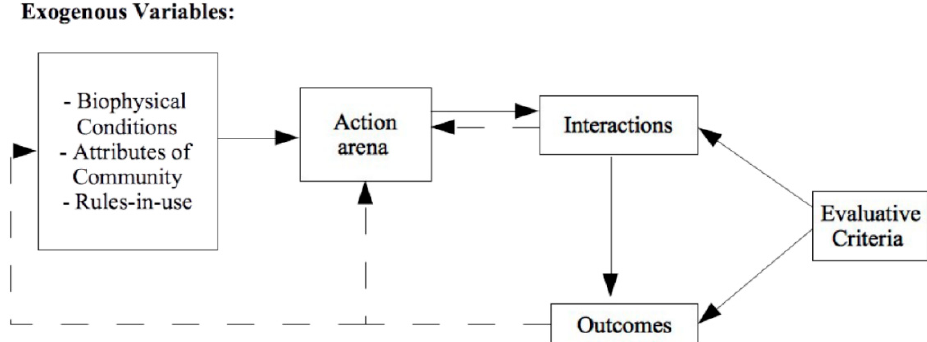
Figure 1. Institutional Analysis and Development framework. Developed based on [16,19–22,24].